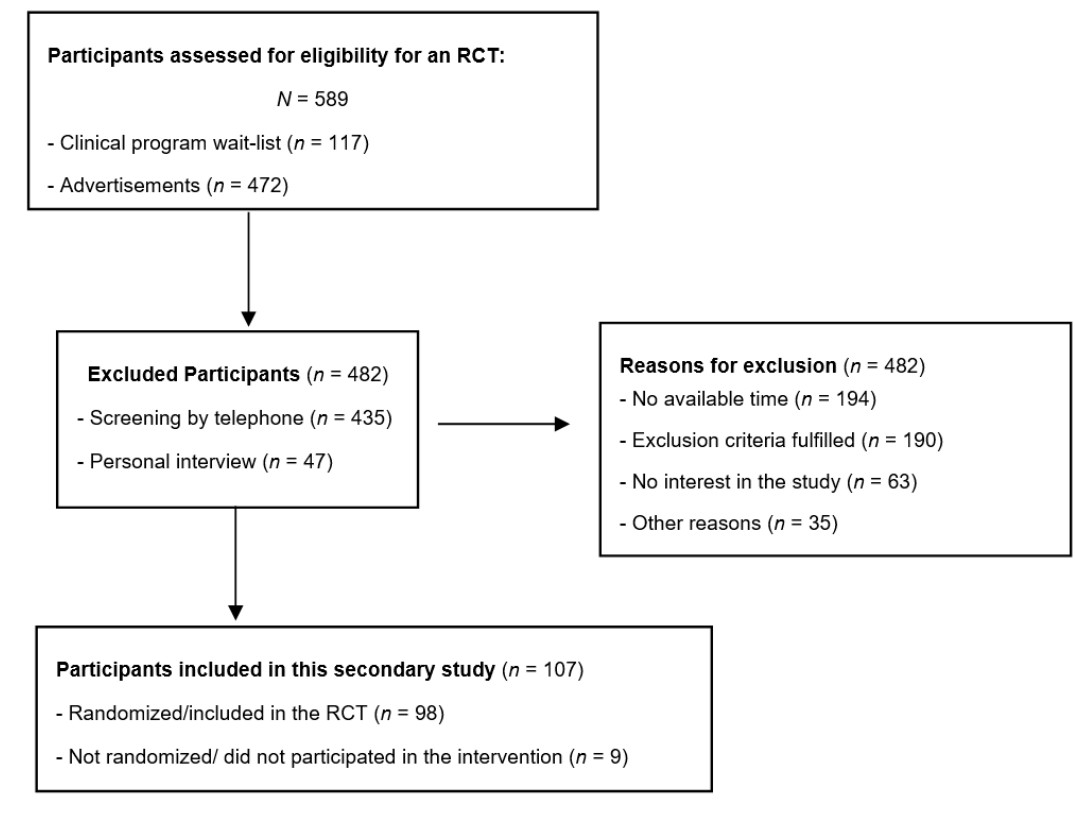
Figure 1. Flow chart of patient selection.